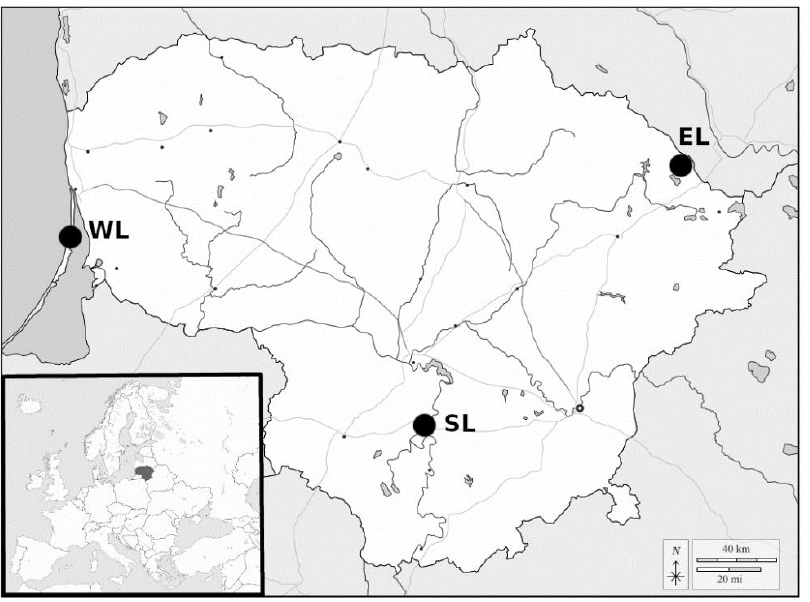
Figure 1. Investigation sites in Lithuania. The shore of the Curonian Lagoon in Western Lithuania (WL), the bank shore of the Nemunas River in Southern Lithuania (SL), the Peninsula of Lukštas Lake in Eastern Lithuania (EL).